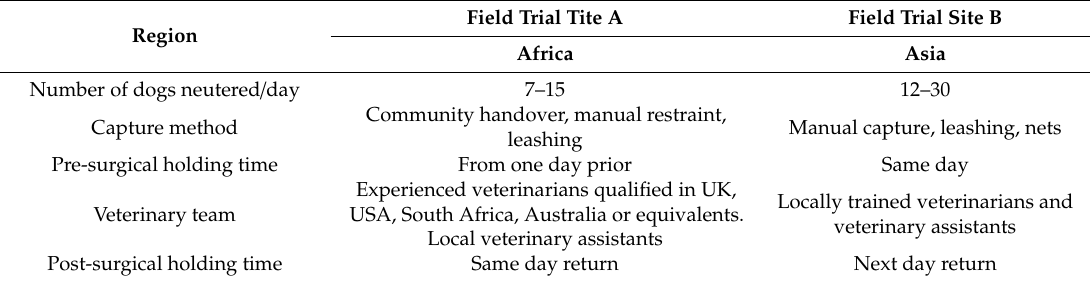
Table 2. Comparison of the primary characteristics of two CNR projects used as field trial sites, highlighting the variations in the two